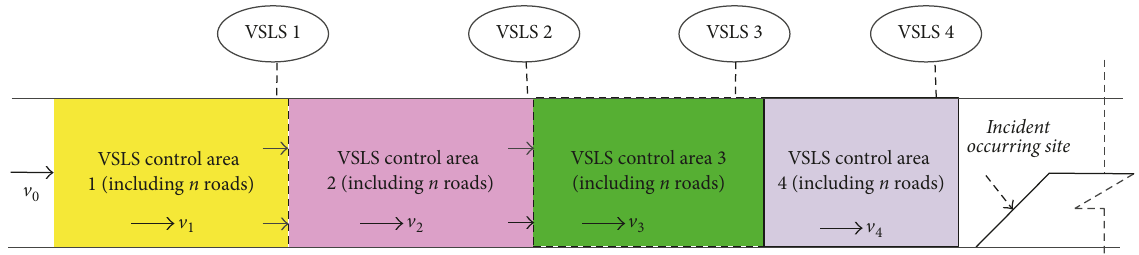
Figure 5: The division of VSLS control